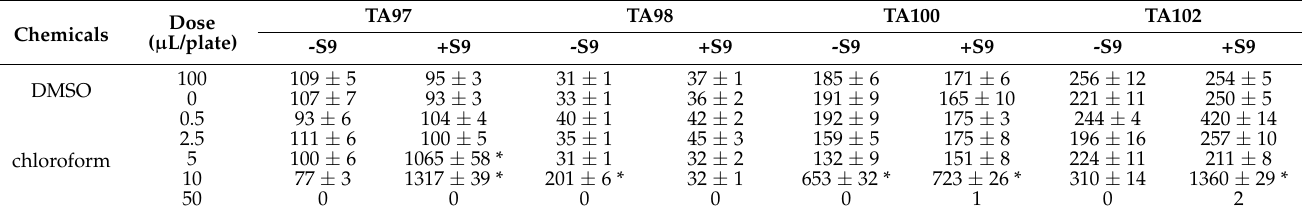
Table 2. Reverse mutation colonies of four S. typhimurium strains exposed to chloroform with and without S9. Chemicals